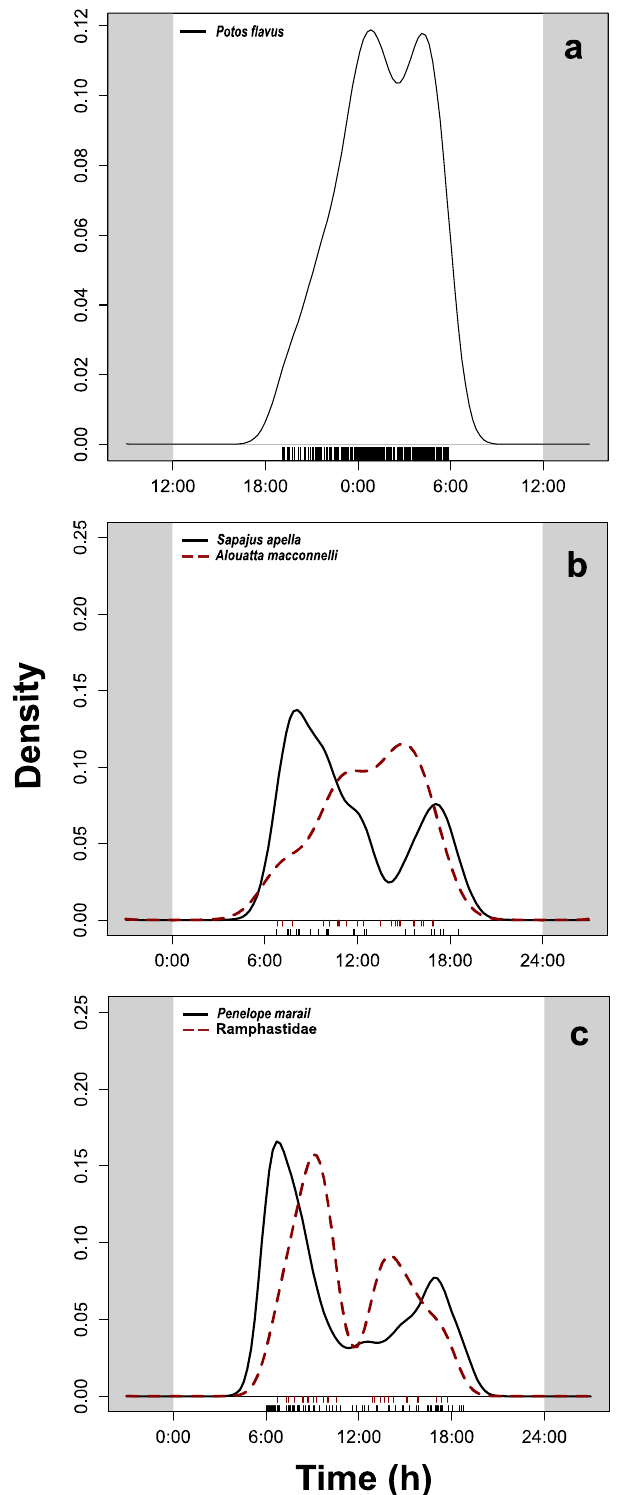
Figure 3. Night activity of ( a ) kinkajou ( Potos flavus ), and daily activity of ( b ) primates ( Alouatta macconnelli and Sapajus apella ) and ( c ) birds ( Penelope marail and Ramphastidae, toucans) in Virola spp trees near National 2 Road between 12/01/19 and 01/24/20. Small bars (x-axis) represent recorded events: the greater the number of events observed at a given time, the greater the density